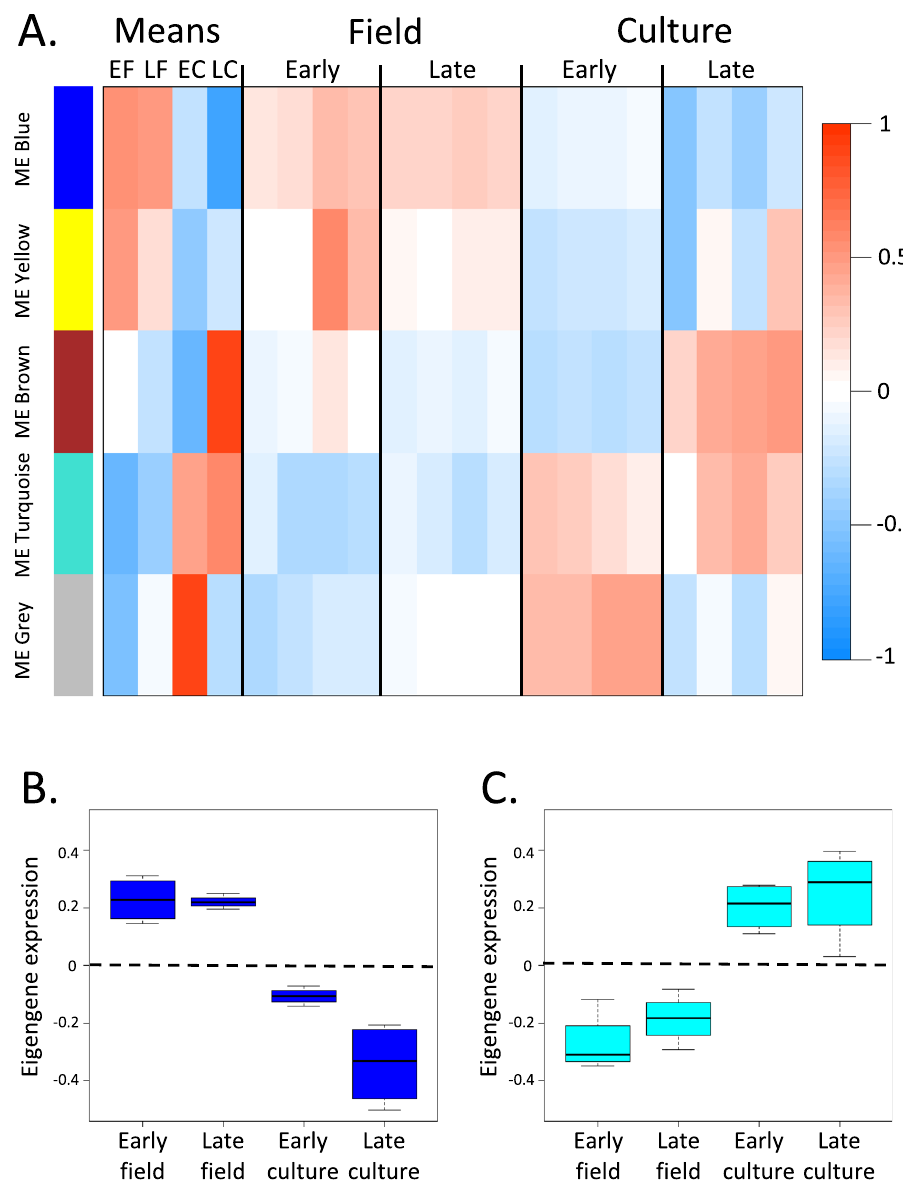
Fig. 4 Correlation network analysis (WGCNA) of DEGs showing modules of genes with similar expression patterns. A WGCNA network signi fi cance correlation matrix. Heatmap of correlation of module eigengenes with sample traits (rows correspond to modules [labeled by color] and columns to groups or individual samples). The fi rst four columns represent the correlation of module eigengenes with each group (diapause program: early fi eld [EF], late fi eld [LF]; reproductive program: early culture [EC], late culture [LC]). Columns on the right (16) are the correlations of the eigengene expression for each module with the individual samples. Direction and the strength of correlation are indicated by color with blue showing negative (downregulation) and red showing positive (upregulation) (color scale on right). Number of genes in the four major modules: blue ( n = 3827), yellow ( n = 745), brown ( n = 1133), turquoise ( n = 5689). A small number of DEGs were placed into the “ unassigned ” gray module ( n = 109). B Box and whiskers plot of the blue module eigengene expression for each group ( n = 4). C Box and whiskers plot of the turquoise module eigengene values for each group ( n = 4). The box displays the median and interquartile range, while the whiskers give the minimum and maximum values for each samples, as shown in the box and whiskers plots of module the turquoise module. ‘ Glycerophospholipid biosynthetic process ’ eigengene expression (Fig. 4B, C, see “ Methods ” ). DEGs in the blue module were positively correlated with CVs on the diapause program (warm colors in fi eld, cool colors in culture), while the DEGs in the turquoise module had the opposite expression pattern (Fig. 4A). Enrichment analysis of the GO terms represented among the DEGs identi fi ed a single over- represented process in each module: ‘ glycerophospholipid summary, this analysis identi fi ed only two key biological biosynthetic process ’ (GO:0046474) in the blue module and ‘ positive regulation of RNA metabolic process ’ (GO:0051254) in culture/reproduction and fi eld/diapause programs.